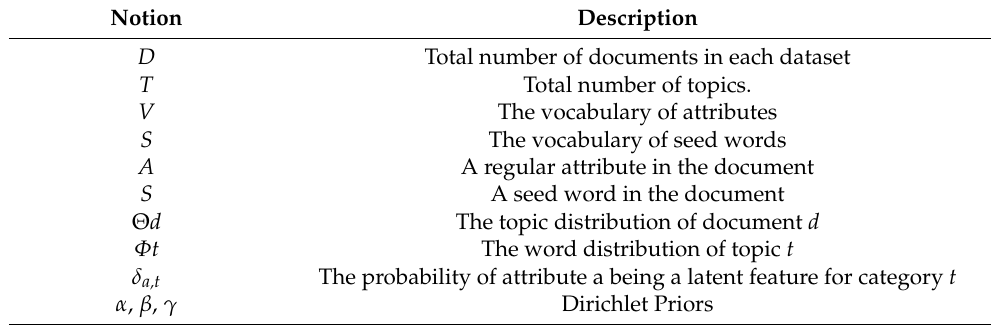
Table 3. List of